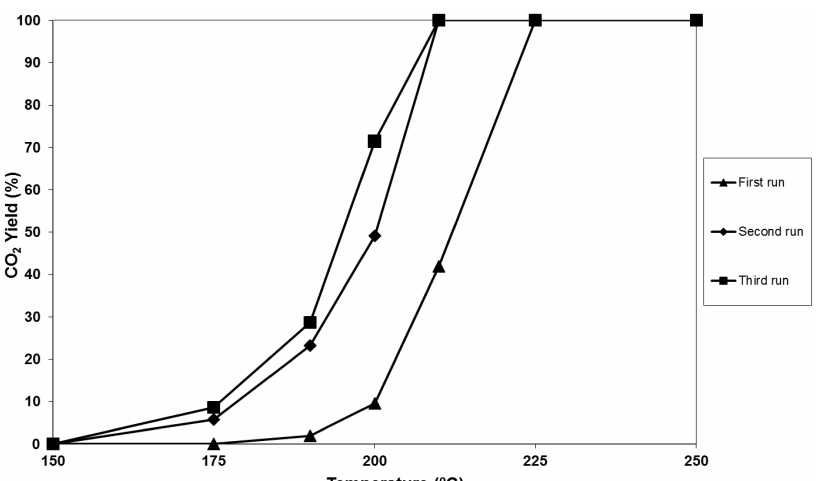
Figure 4. Conversion of naphthalene to CO 2 as a function of temperature for a 2.5 wt.% Pt/SiO 2 catalyst calcined at 550 °C used in repeat cycles: ▲ First cycle; ♦ Second cycle; ■ Third cycle.